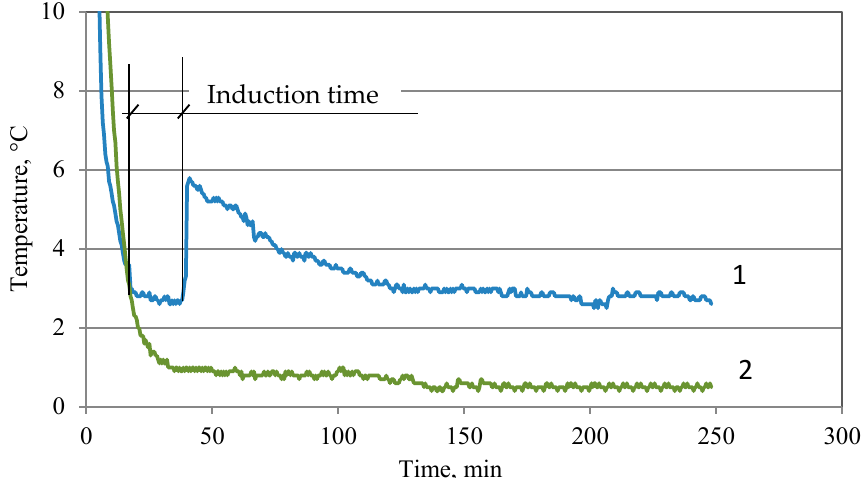
Figure 12. Effect of monoethanolammonium salt of carboxymethylcellulose on hydrate formation in THF-H 2 O. 1—temperature change in the absence of polysaccharides; 2—temperature change in the presence of 0.1% polysaccharides.